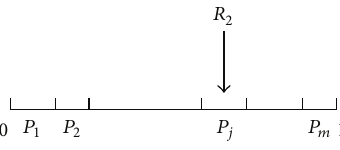
Figure 4: Explanation of system state transition sampling.